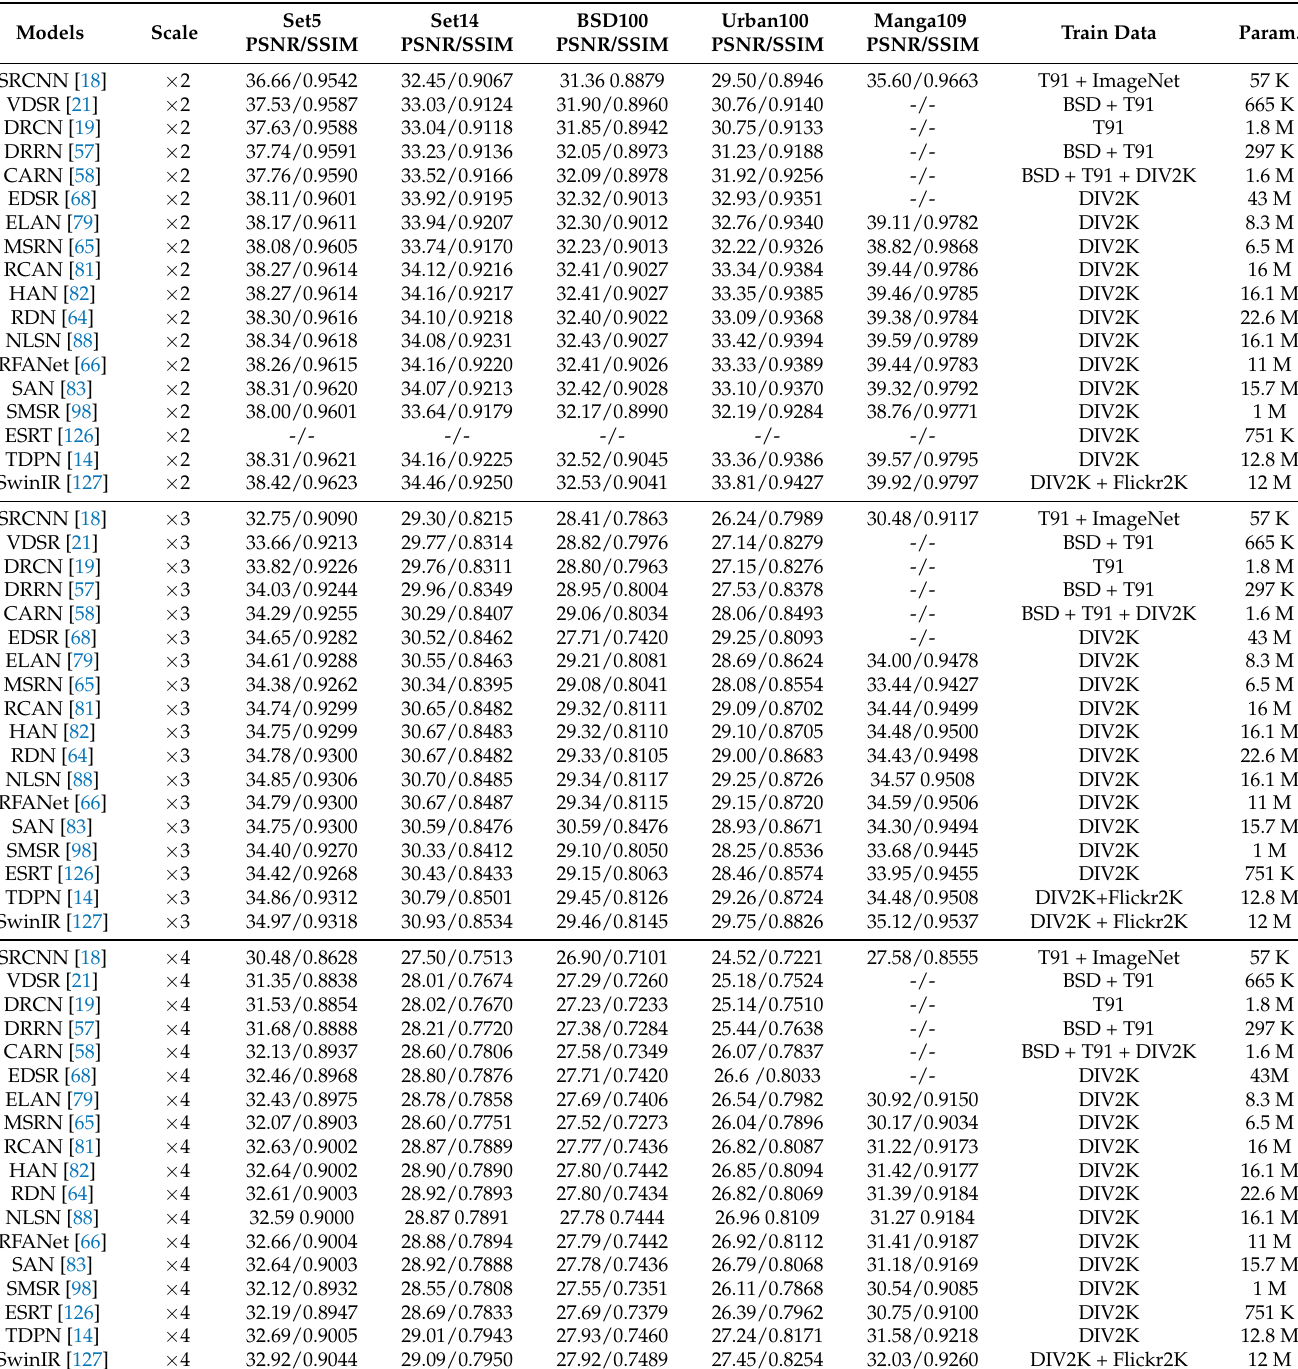
Table 2. PSNR/SSIM comparison on Set5 [35], Set14 [36], BSD100 [32], Urban100 [37], and Manga109 [46]. In addition, the number of training datasets and the parameters of the model are